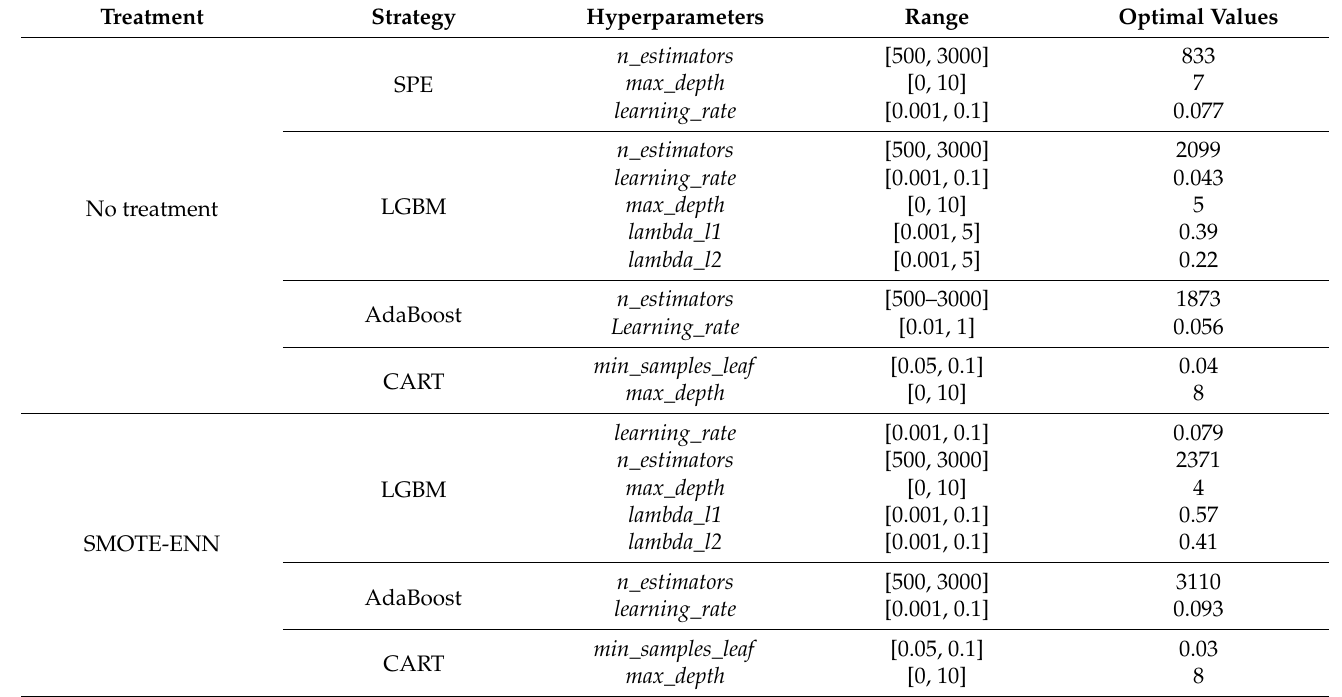
Table 2. Machine learning models hyperparameter